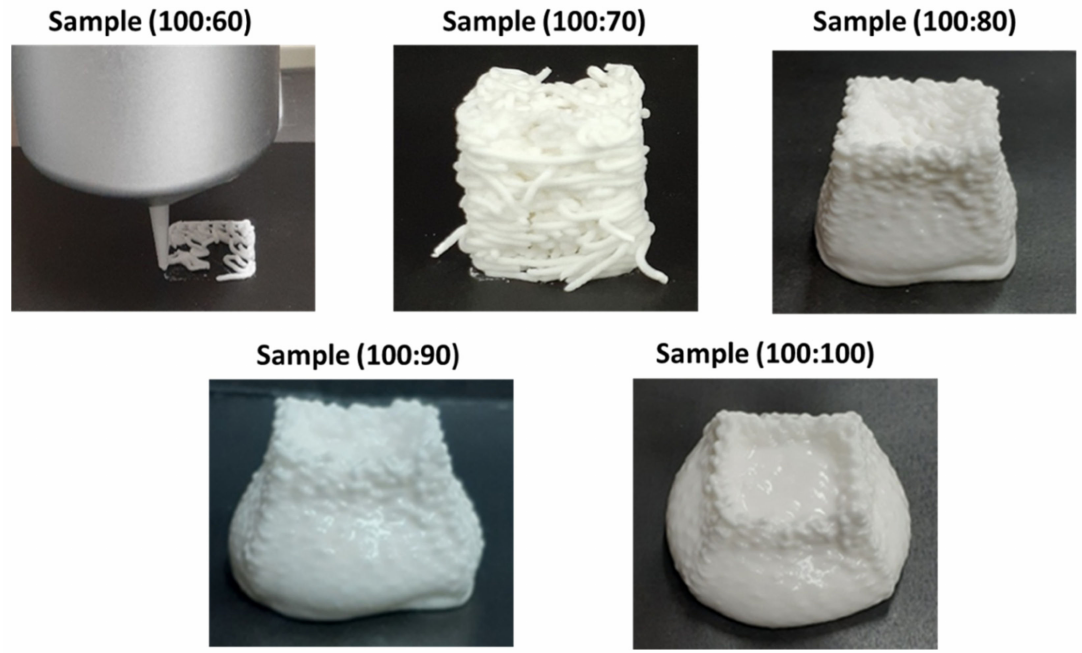
Figure 8. Preliminary printing of rice paste to determine optimum mixture